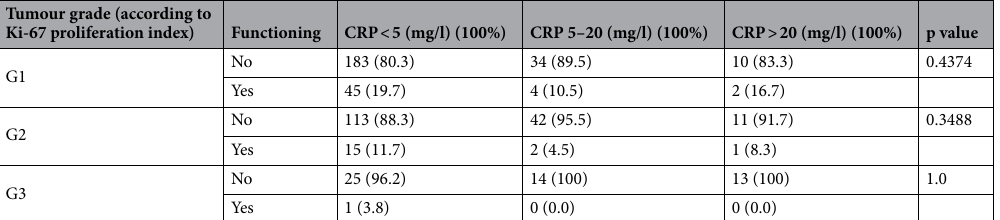
Table 2. Distribution of serum CRP groups according to tumour grade and functioning versus non- functioning pNEN.